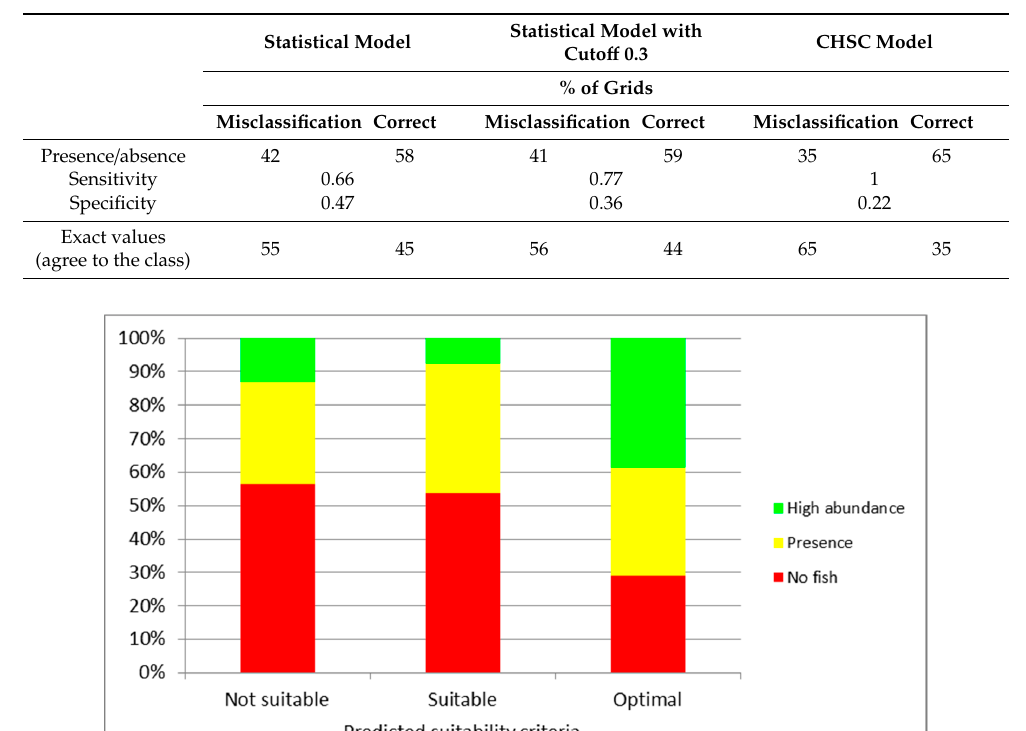
Table 4. Classification of the results of the models used and fish observations in grids for presence/absence and exact values. In the case of presence/absence confusion, matrix parameters—